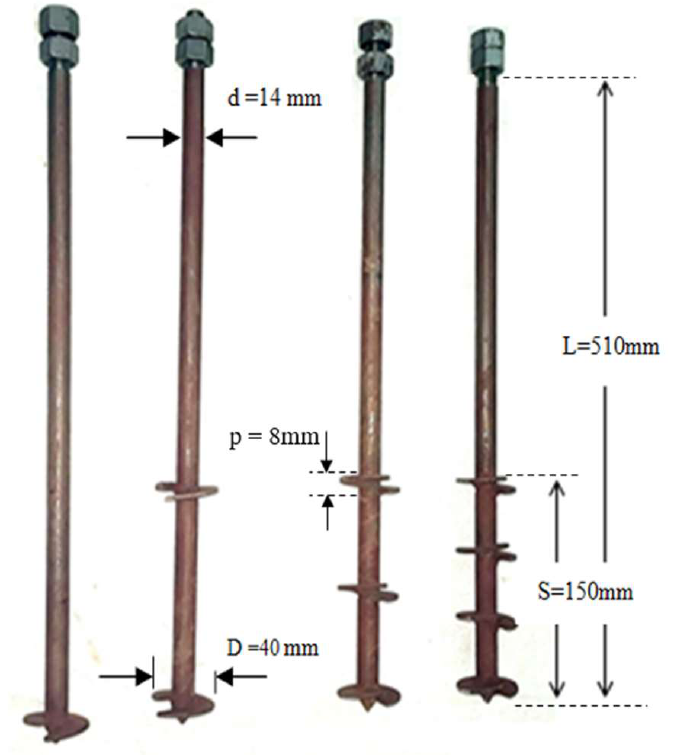
Figure 1. Casted helical piles with dimensions.